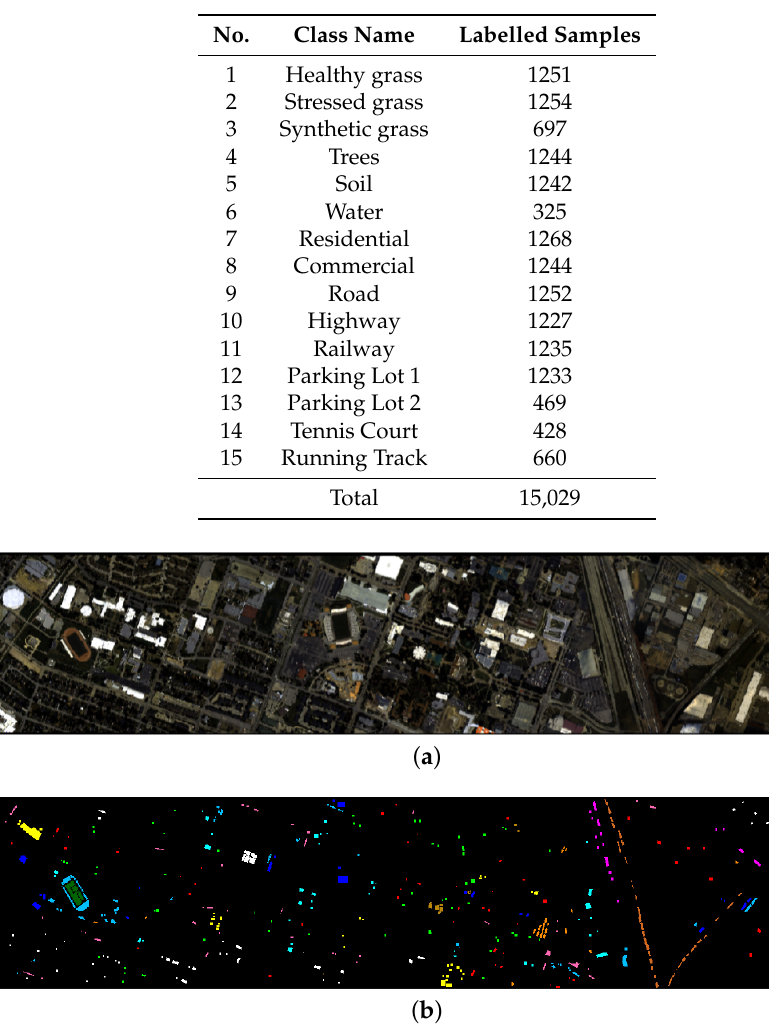
Table 3. Reference classes for the GRSS2013 data set.